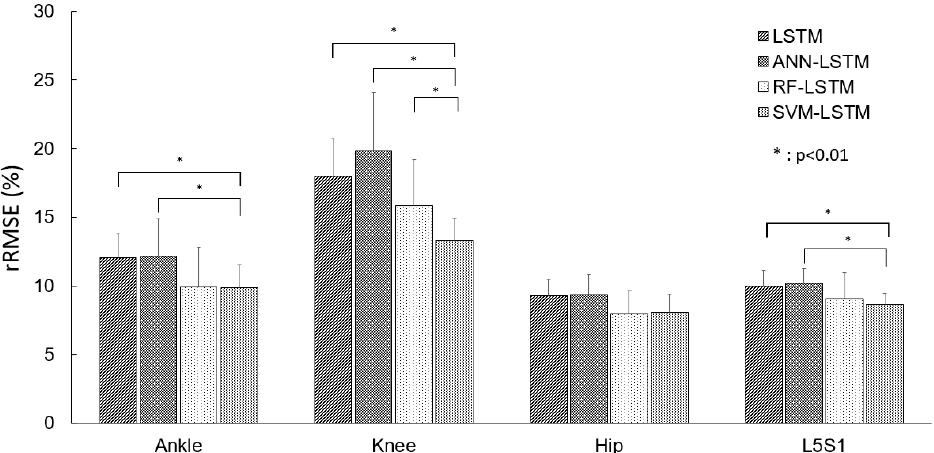
Figure 3. Relative RMSE values between reference moment and predicted moment by deep learning models.